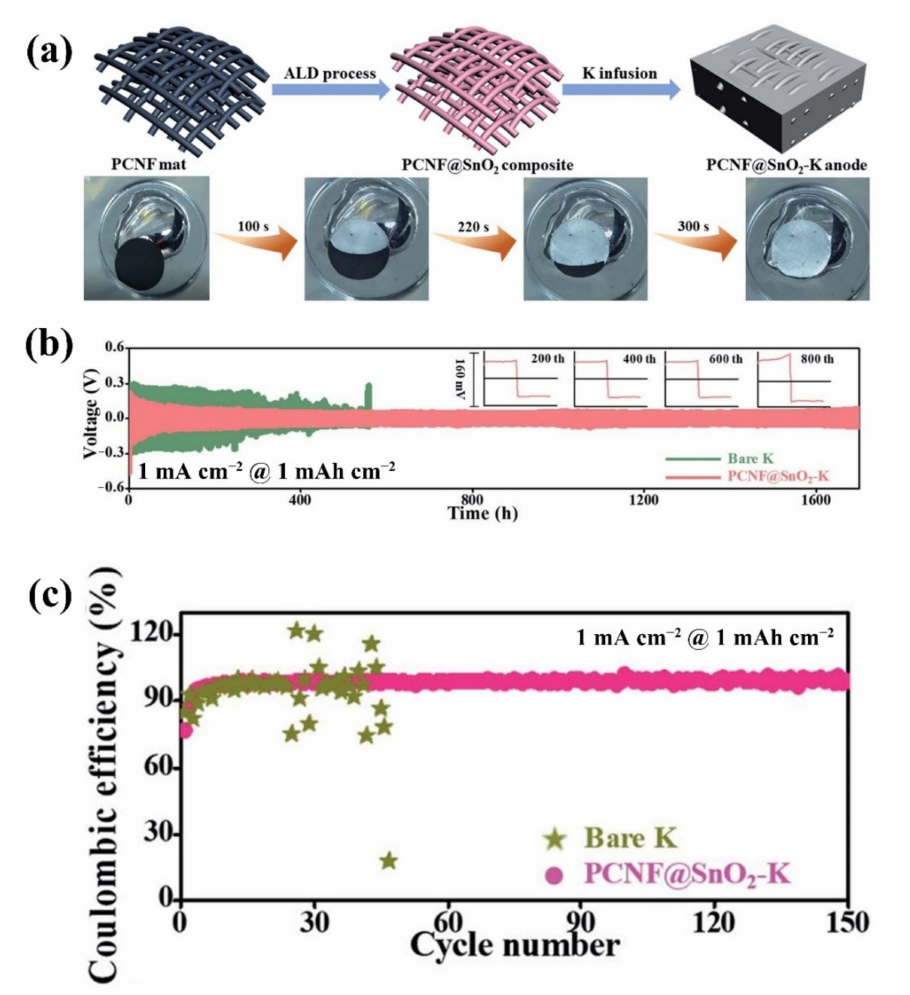
Figure 6. ( a ) Metallic infusion of K into the PCNF-SnO 2 composite mat, ( b ) Symmetric K-K cell cycling performance of PCNF mats and bare K metal, and ( c ) CE of the PCNF@SnO 2 -K composite and bare K anodes at current density of 1 mA cm − 2 and areal capacity of 1 mAh cm − 2 [111] Reproduced with permission [111]. Copyright 2020, The Royal Society of